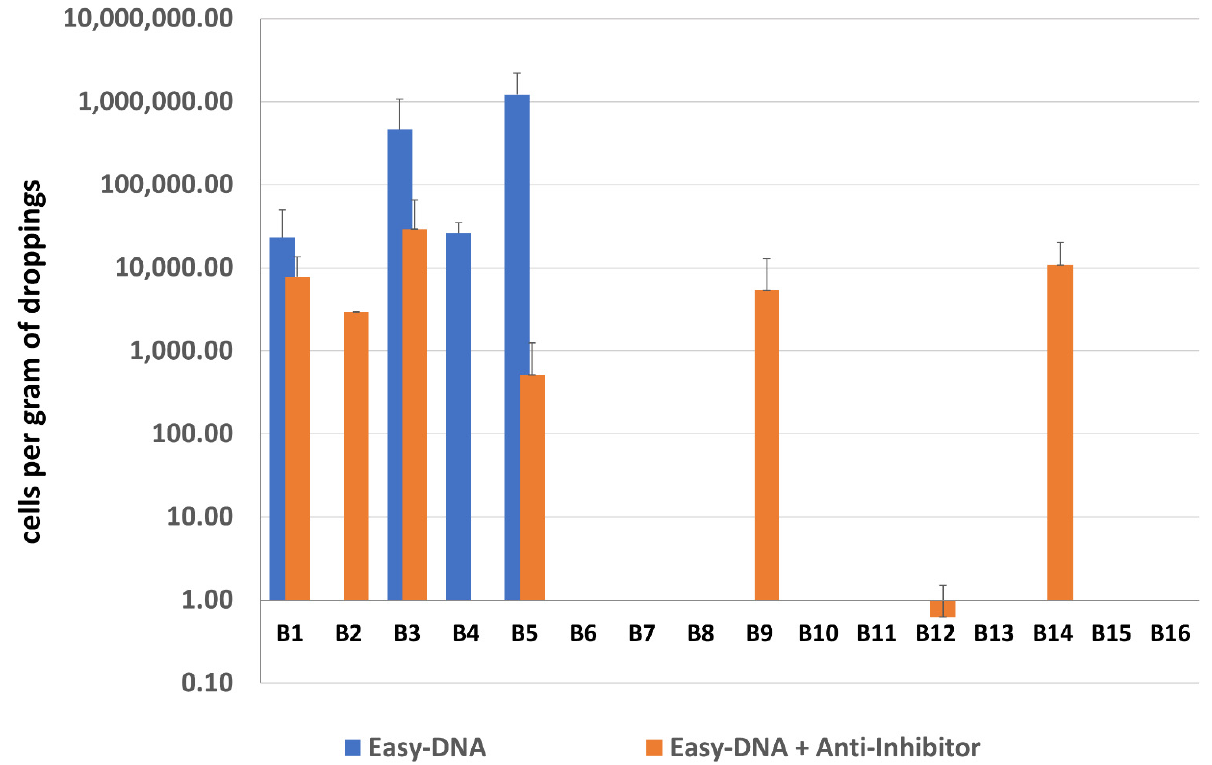
Figure 4. The quantification results of methanogenic archaea in samples